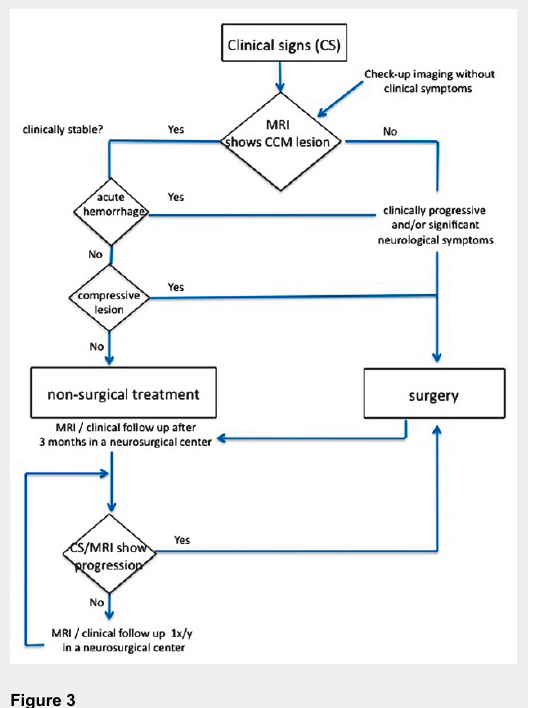
Figure 3 Flowchart to differentiate between nonsurgical versus surgical management in patients with brainstem